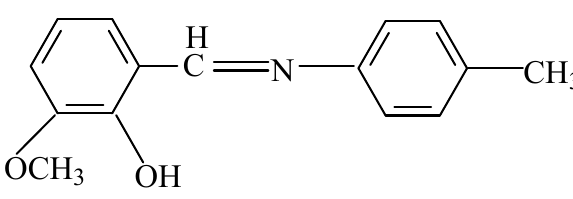
Figure 3. Structure of Schiff base